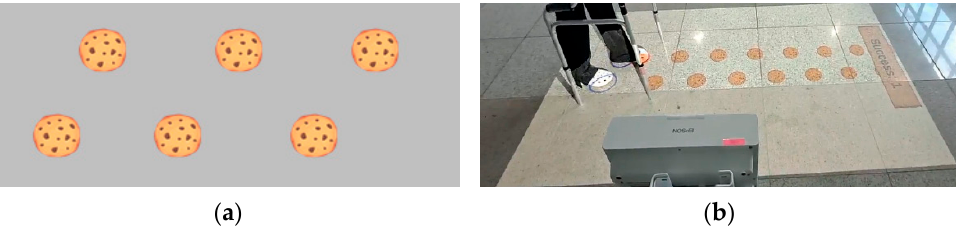
Figure 8. An experiment for foot recognition: ( a ) a captured image of content used for the experiment; ( b ) a photograph of experiment for foot recognition.